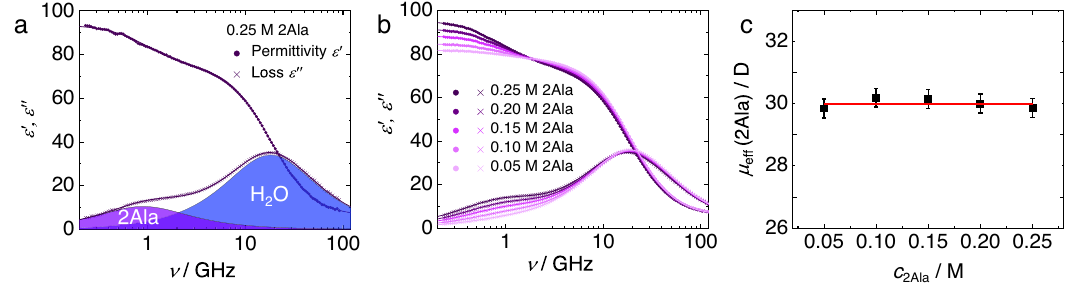
Fig. 2 Dielectric spectra of aqueous 2Ala solutions are consistent with uncorrelated dipolar rotation of 2Ala. Complex permittivity spectrum of ( a ) 0.25 M aqueous 2Ala solution and b aqueous 2Ala solutions with increasing concentration of 2Ala. Solid circles and crosses show the experimental dielectric permittivity ( ε ′ ) and dielectric loss spectra ( ε ″ ), respectively. Solid lines show fi ts of Eq. (1) to the experimental data. The contribution of the 2Ala and the water relaxations to the dielectric loss are shown as shaded areas in ( a ). Conductivity contributions (last term of Eq. (1)) have been subtracted for visual clarity in ( a , b ). c Shows the constant effective dipole moment of 2Ala µ eff (2Ala) as calculated from the 2Ala relaxation amplitude as a function of 2Ala concentration. Error bars are based on the standard deviation within eight independent